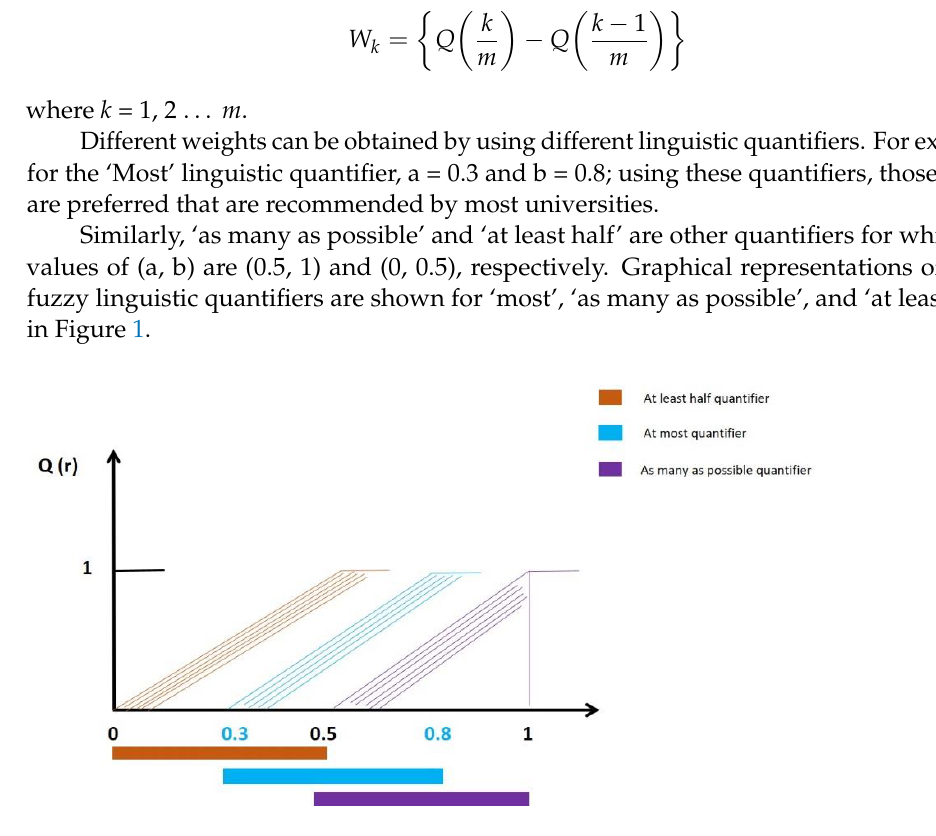
Figure 1. Graphical representation of linguistic quantifier ‘as many as possible’, ‘at most’ and ‘at least half’ quantifiers colored in violet, blue and brown, respectively.